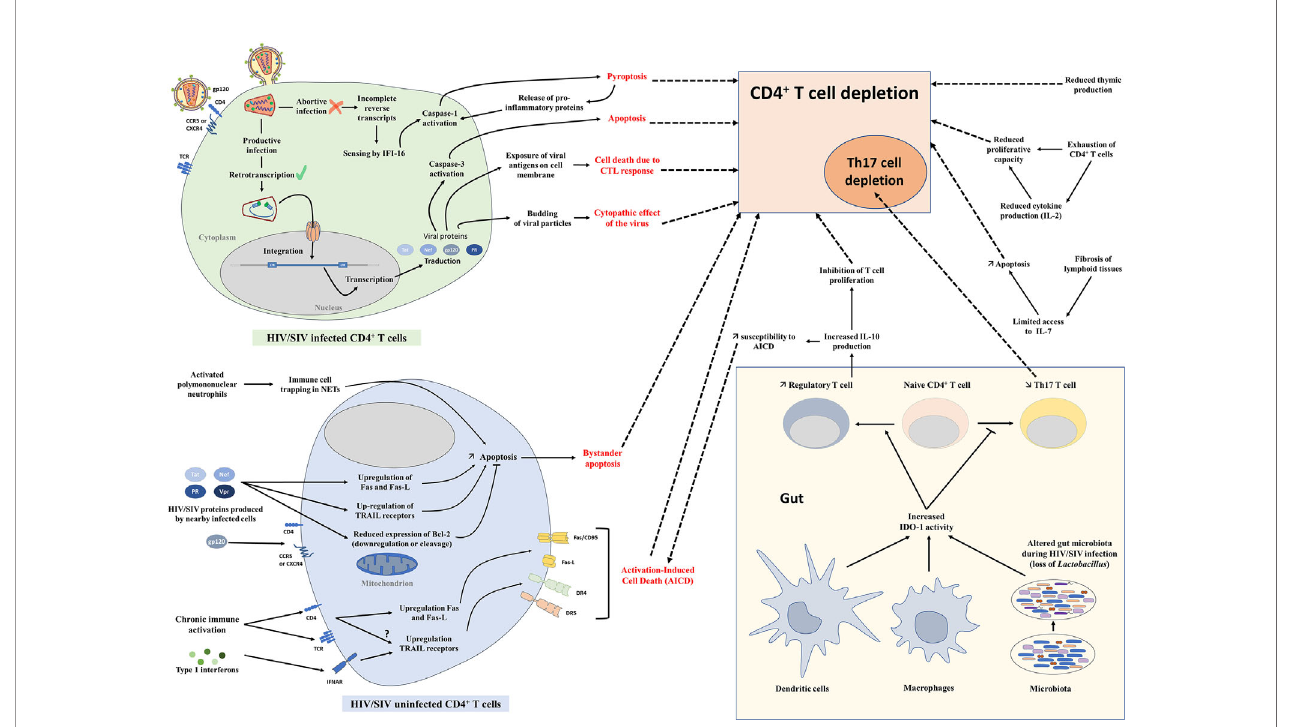
FIGURE 2 | Mechanisms of CD4 + T-cell depletion. Schematic representation of different mechanisms involved in CD4 + T-cell depletion during HIV and SIV infections. AICD, Activation-induced cell death; CTL, Cytotoxic T lymphocytes; IDO-1, Indoleamine 2,3-dioxygenase 1; NETs, Neutrophil extracellular